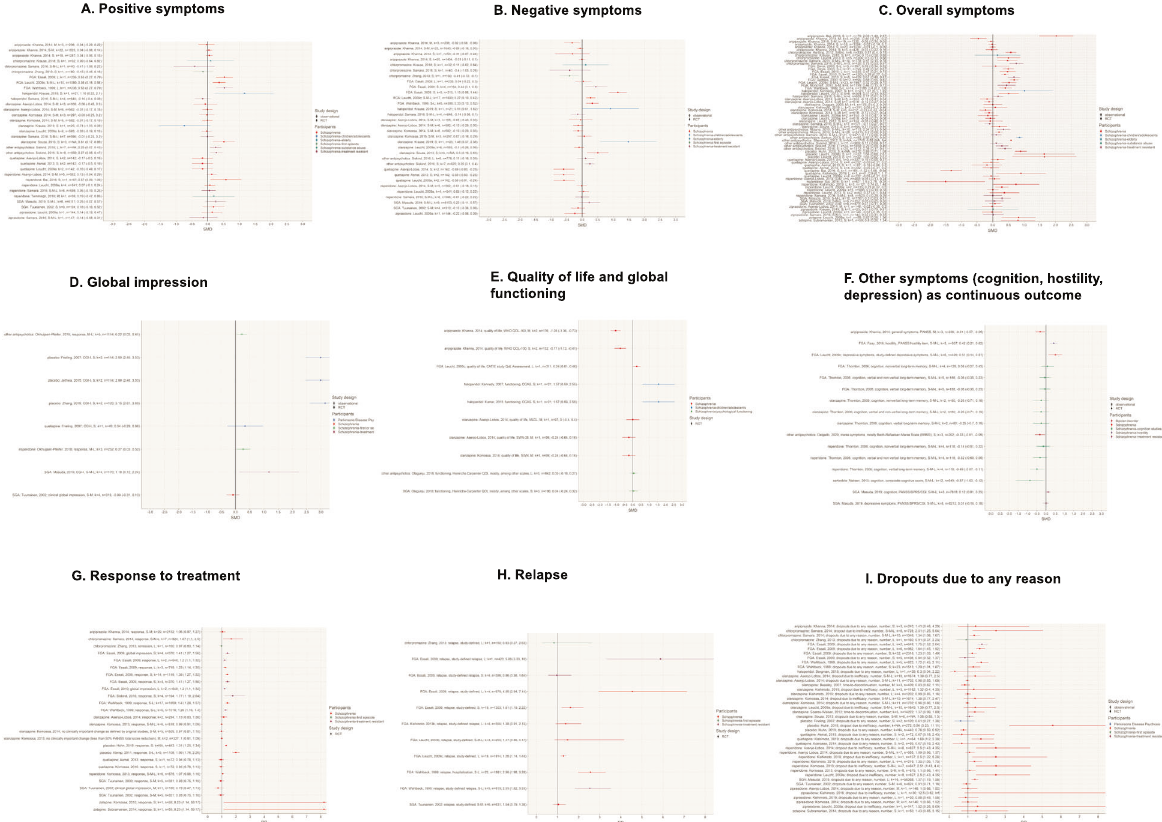
Fig. 2 Quantitative meta-review of clozapine-speci fi c meta-analytic data: Ef fi cacy. A Positive symptoms. FGA fi rst-generation antipsychotic, k number of studies, L long-term, M medium-term, n number of participants, RCT randomized controlled trial, S short-term, SGA second- generation antipsychotic. Abbreviated study descriptions: Leucht et al., 2009a [76], Leucht et al., 2009b [76], Leucht et al., 2009c [79]. For continuous outcomes, SMD > 0 means a bene fi cial outcome for clozapine (e.g. more response or less adverse events. B Negative symptoms. FGA fi rst-generation antipsychotic, k number of studies, L long-term, M medium-term, n number of participants, RCT randomized controlled trial, S short-term, SGA second-generation antipsychotic. Abbreviated study descriptions: Leucht et al., 2009a [76], Leucht et al., 2009b [76], Leucht et al., 2009c [79]. For continuous outcomes, SMD > 0 means a bene fi cial outcome for clozapine (e.g. more response or less adverse events. C Overall symptoms. FGA fi rst-generation antipsychotic, k number of studies, L long-term, M medium-term, n number of participants, RCT randomized controlled trial, S short-term, SGA second-generation antipsychotic. Abbreviated study descriptions: Leucht et al., 2009a [76], Leucht et al., 2009b [76], Leucht et al., 2009c [79]. For continuous outcomes, SMD > 0 means a bene fi cial outcome for clozapine (e.g.